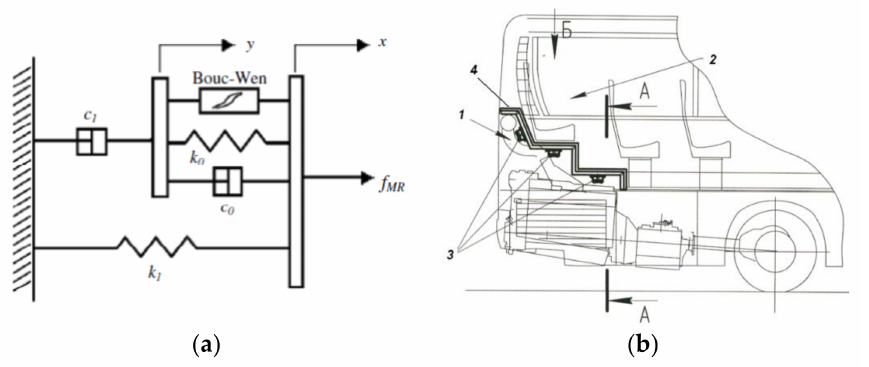
Figure 3. Mechanical model of MR damper ( a ), and general appearance of a bus soundproofing system ( b